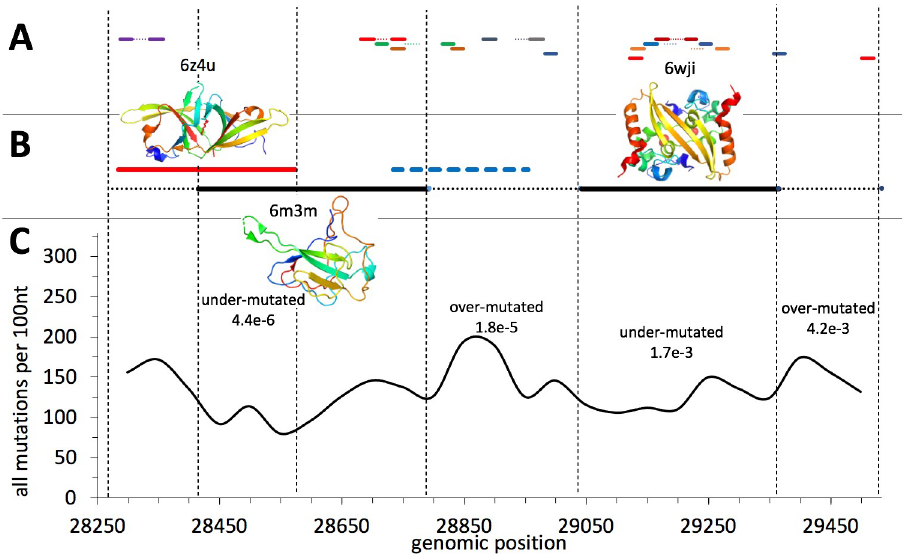
reading frames: Orf9b is shown in red, Orf14 –in blue and Nucleocapsid–in black. The regions coding for experimentally verified stable protein structures are shown as continuous lines and regions known to be structurally disordered—as dotted lines. Orf14, whose protein structure remains to be determined is shown as a dashed line. C) The rate of all (missense + synonymous) mutations per 100 nt windows. P-values from binomial tests are given for regions which are significantly under- or over-mutated (the entire Nucleocapsid ORF was used as a